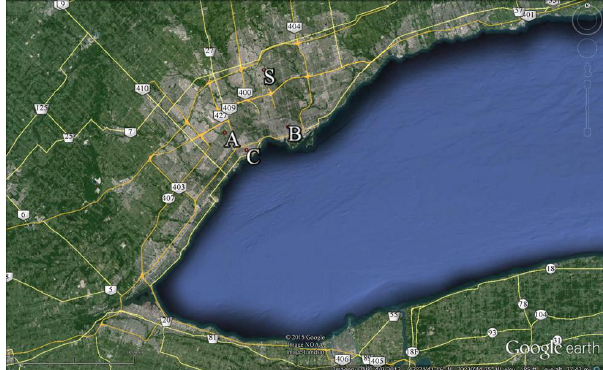
Figure 1. Location of sampling site in Toronto (S). Also shown are the locations for VOC sampling by the National Air Pollu- tion Surveillance Program (NAPS) in Toronto (A: Elmcrest Road, Toronto, ON, Canada; B: 223 College St., Toronto, ON, Canada; C: 461 Kipling Ave., Toronto, ON, Canada). The map was produced using Google Earth ( © 2015).